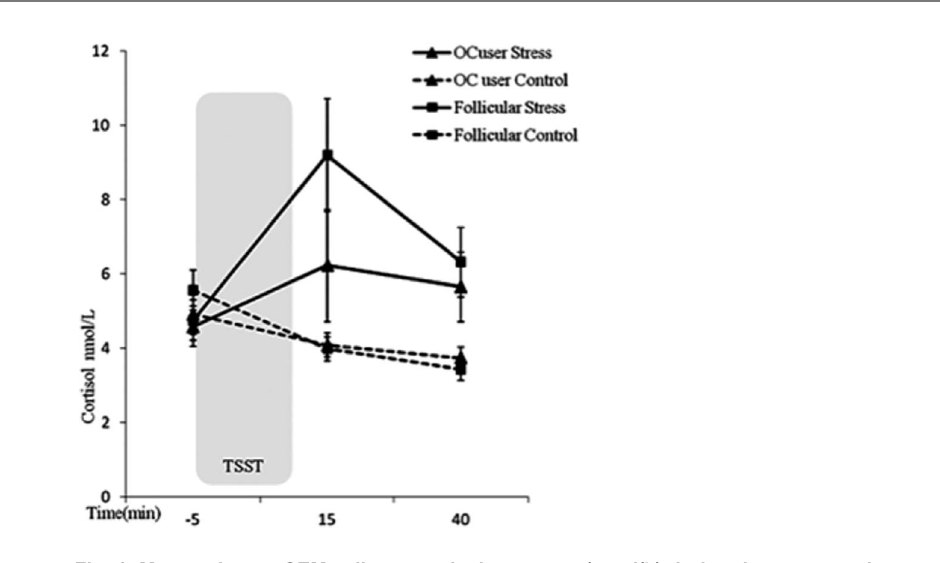
Fig. 1. Mean values ¡ SEM salivary cortisol response (nmol/L) during the stress and control conditions by group (* p ,